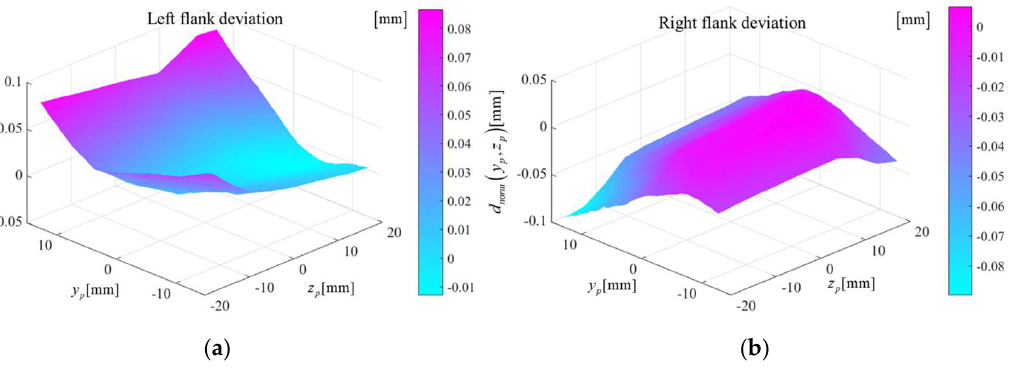
Figure 8. Topological deviation map of tooth flank. ( a ) Left flank deviation. ( b ) Right flank deviation.